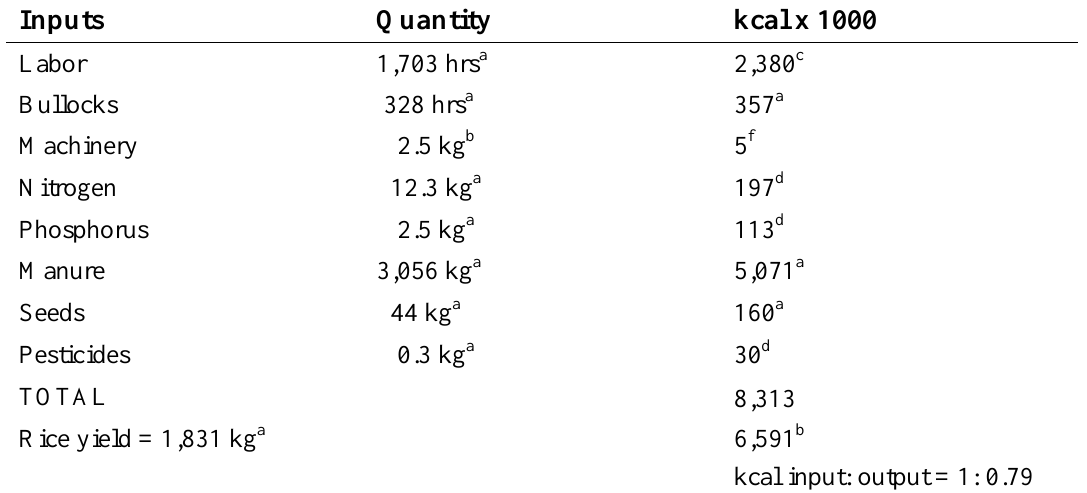
Table 8. Energy inputs of draft animal-produced rice per hectare in the Valley of Garhwal Himalaya,